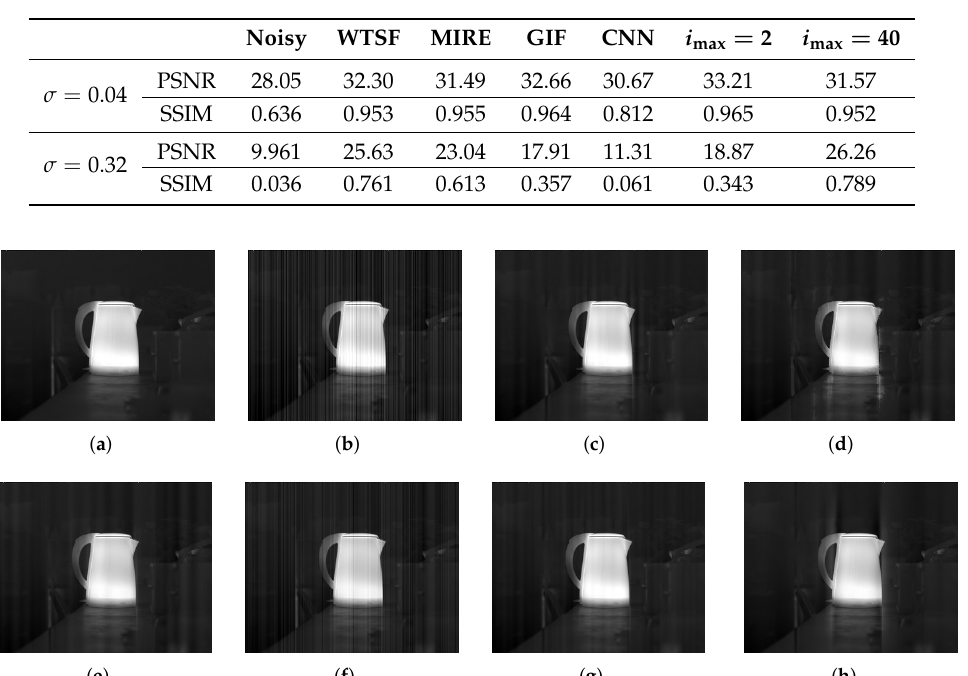
Figure 15. Filtered results for Kettle corrupted by stripe niose with σ = 0.04. ( a ) Clean; ( b ) Noisy; ( c ) WTSF; ( d ) MIRE; ( e ) GIF; ( f ) CNN; ( g ) Ours with i max = 2; ( h ) Ours with i max =